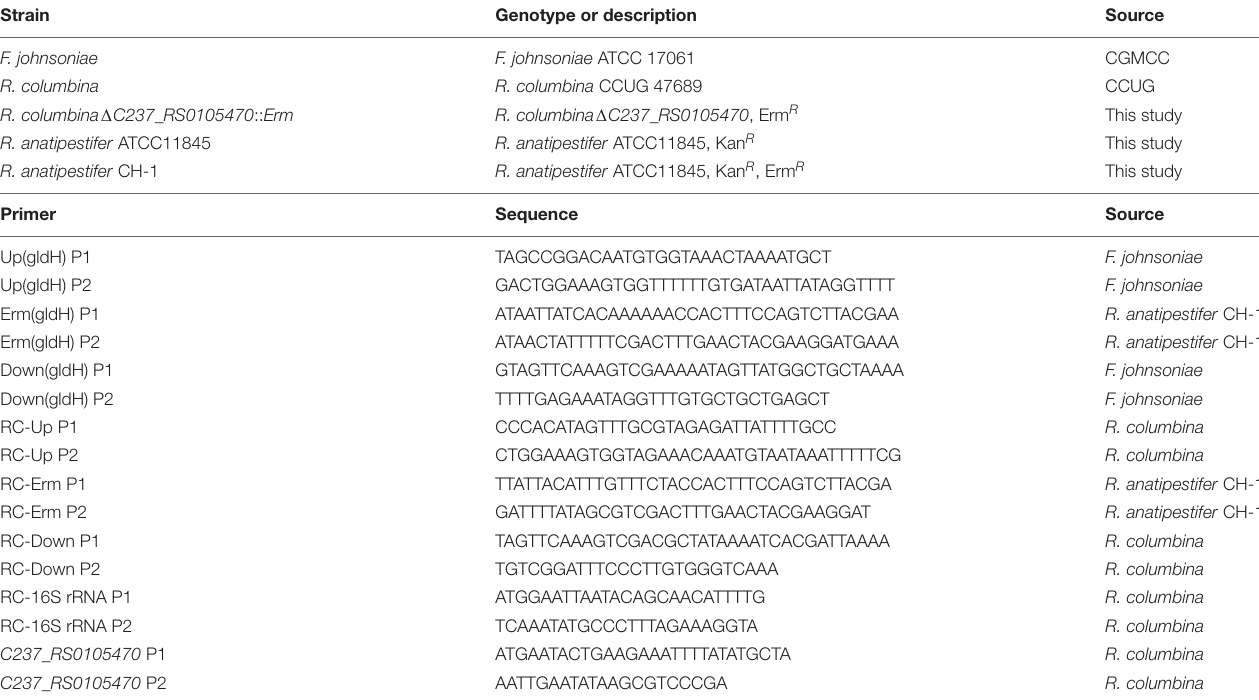
TABLE 1 | Strains and primers used in this